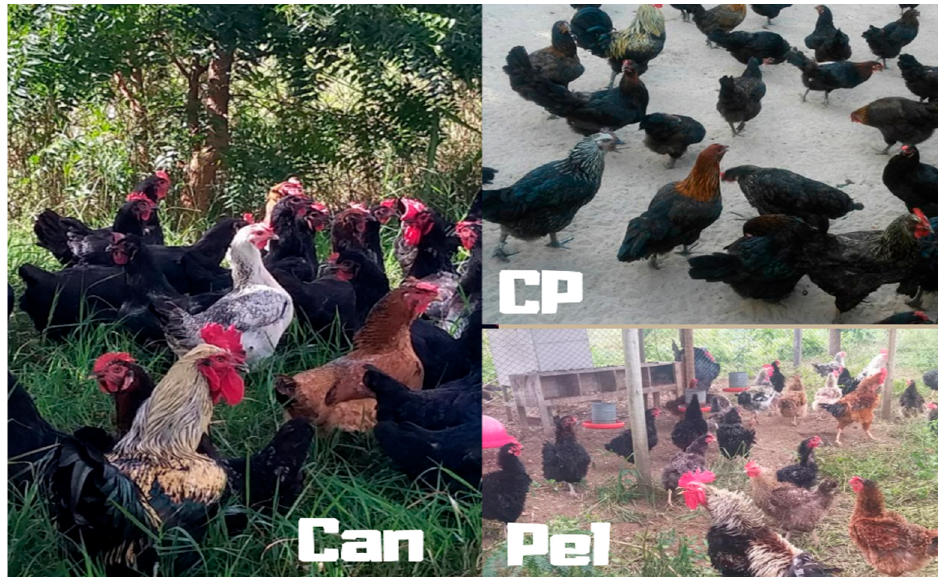
Figure 1. Chicken breeds from the northeast region of Brazil. CP, Canela-Preta; CAN Caneluda do Catolé; PEL, Peloco (Source of pictures: Débora Carvalho and Ronaldo Vasconcelos).